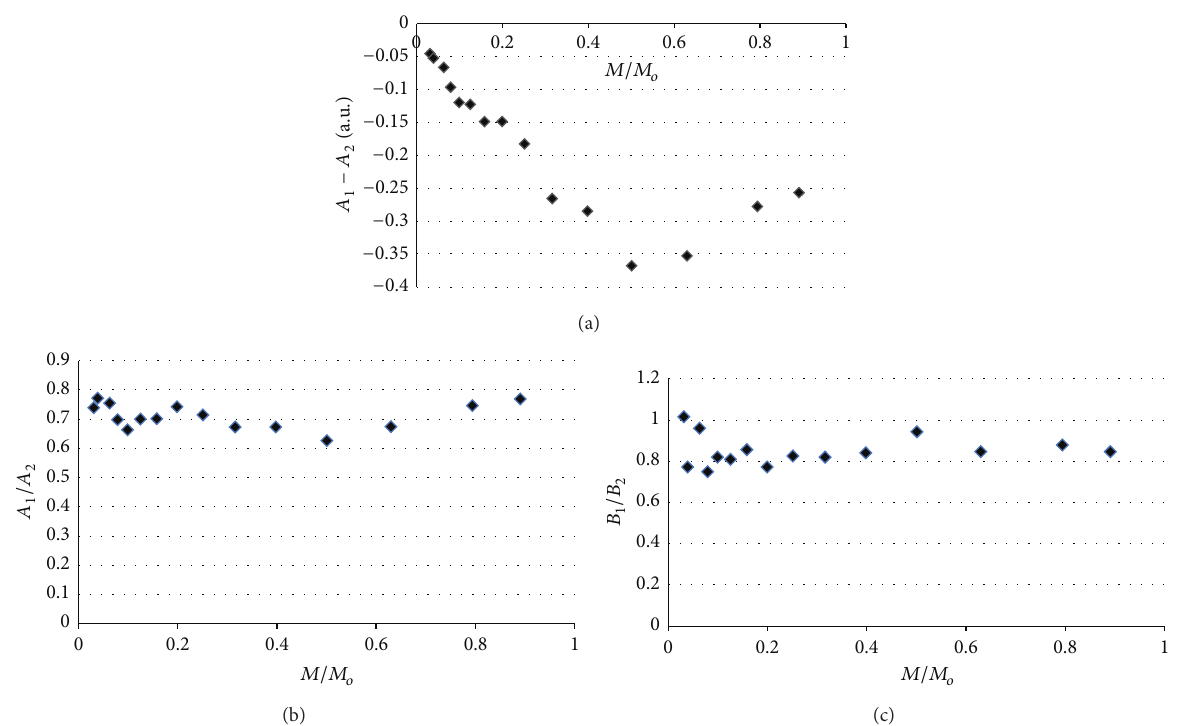
Figure 7: The effect of microwave power on the line shape parameters: (a) 𝐴 1 −𝐴 2 , (b) 𝐴 1 /𝐴 2 , and (c) 𝐵 1 /𝐵 2 , for the EPR spectra of bismuth subgallate thermally sterilized at 160 ∘ C (120 minutes). 𝑀 —microwave power used during the measurement of the EPR spectra, 𝑀 𝑜 —total microwave power produced by klystron (70 mW).